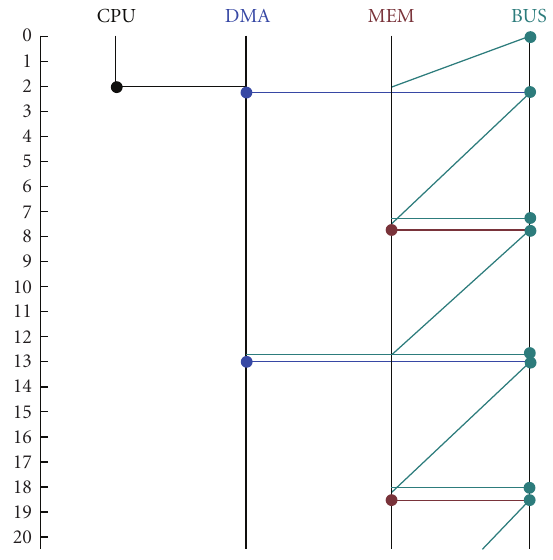
Figure 11: Interaction diagram generated by the system